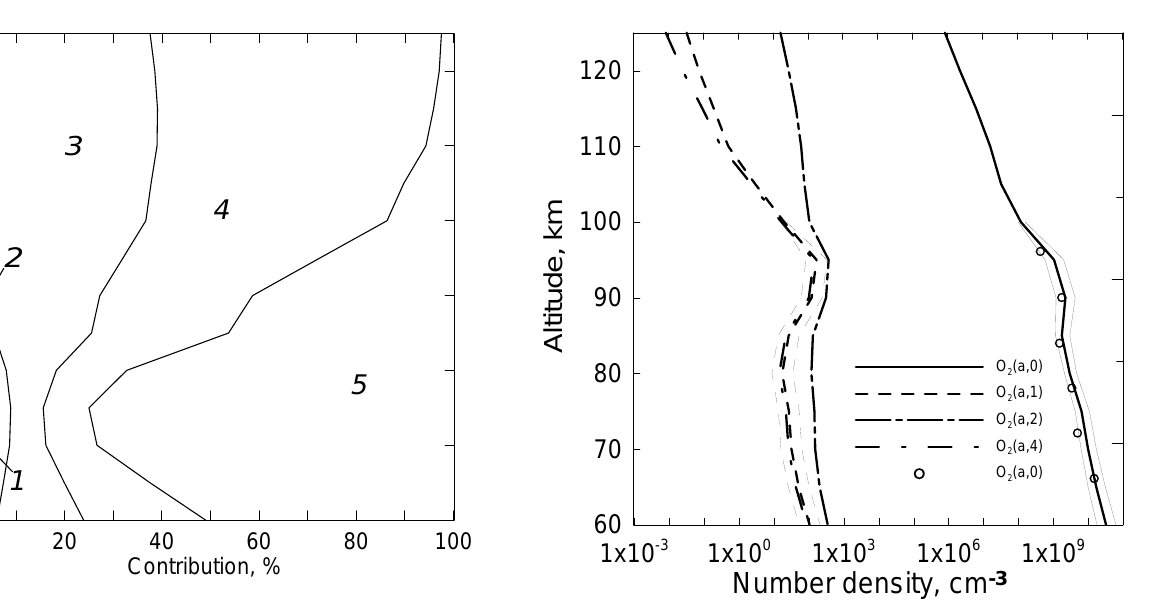
Fig. 3. Areas of diagram indicate the relative contributions of direct Fig. 4. Altitude profiles of the number densities of the molecules in and indirect processes to the total rate of O 2 (b 1 6 + g , v=0) produc- the states O 2 (a 1 1 g , v) for v=0, 1, 2 and 4. The bold curves – cal- tion, in percent. Indirect processes: 1 – absorption of solar radi- culations for the conditions of experiment METEORS (Mlynczak ation O 2 + h ν (629nm) → O 2 (b 1 6 + g , v=2) (magnified by 10); 2 – et al., 2001) in accordance with our model. Circles – experimen- absorption of solar radiation O 2 + h ν (689nm) → O 2 (b 1 6 + g , v=1); 3 tal data of METEORS for O 2 (a 1 1 g . v=0) (Mlynczak et al., 2001). – energy transfer O( 1 D) → O 2 (b 1 6 + g , v=1). Direct processes: 4 – The altitude profiles of number densities of molecules in the states energy transfer O( 1 D) → O 2 (b 1 6 + g , v=0); 5 – absorption of solar O 2 (a 1 1 g , v) for v=0 and 1, calculated for two ozone altitude pro- radiation O 2 + h ν (762nm) → O 2 (b 1 6 + g , v=0). files [O 3 ] 0 at variations of [O 3 ] 0 /[O 3 ] equal to 0.5 and 2.0, are shown by thin grey v=0) → O 2 (X 3 6 − , v=1)+O 2 (b 1 6 + , v=0). The minimum of g g